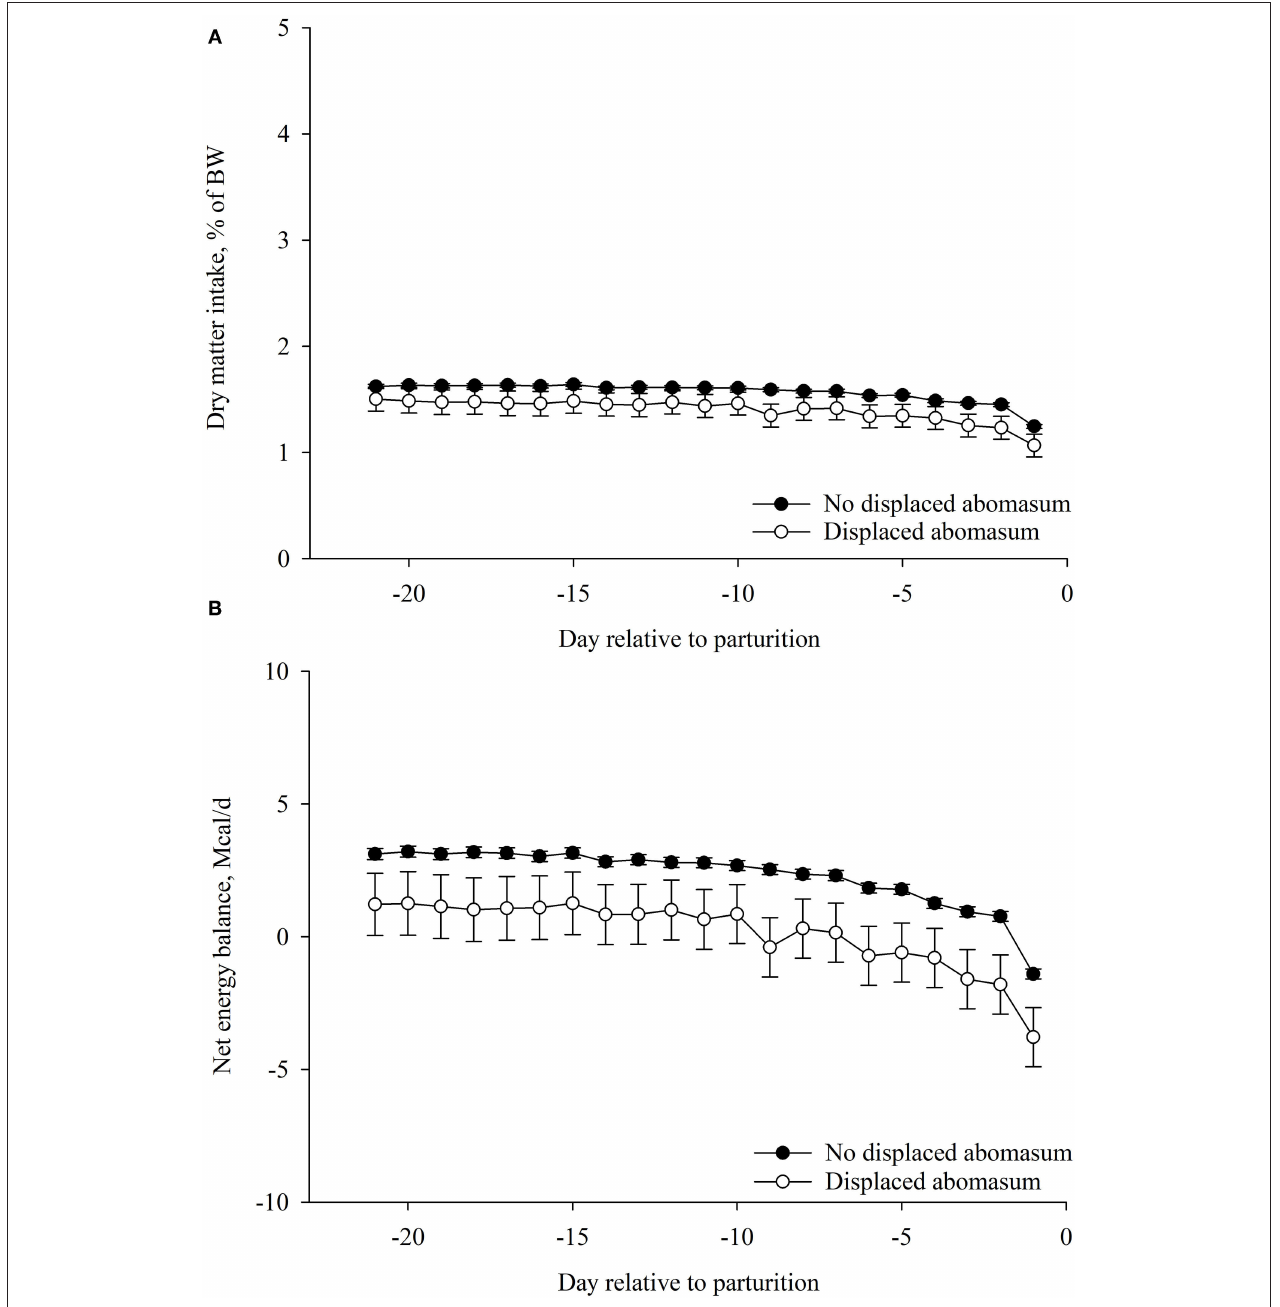
FIGURE 2 | Association of left displaced abomasum postpartum ( n = 26) with (A) dry matter intake (DMI, %BW) and (B) net energy balance (EB, Mcal/day) during the prepartum period (from − 21 to − 1 day relative to parturition). Values are least square means ± SEM. Prepartum DMI (%BW): left displaced abomasum, p = 0.15; day relative to parturition, p < 0.01; and the interaction between left displaced abomasum and day, p = 0.99. Prepartum net energy balance: left displaced abomasum, p = 0.03; day relative to parturition, p < 0.01; and the interaction between left displaced abomasum and day, p = 0.99. * p ≤